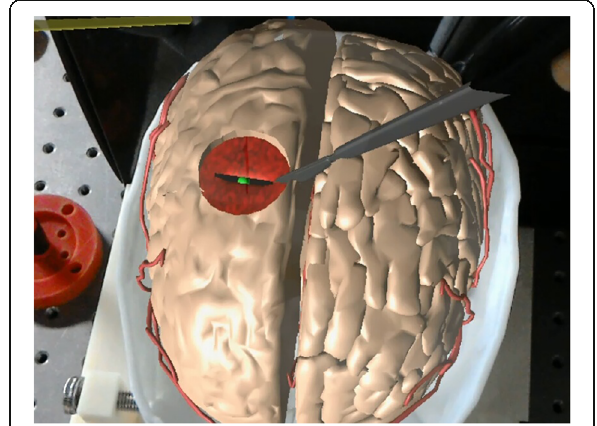
Fig. 4 Biomechanical modeling of neurosurgery